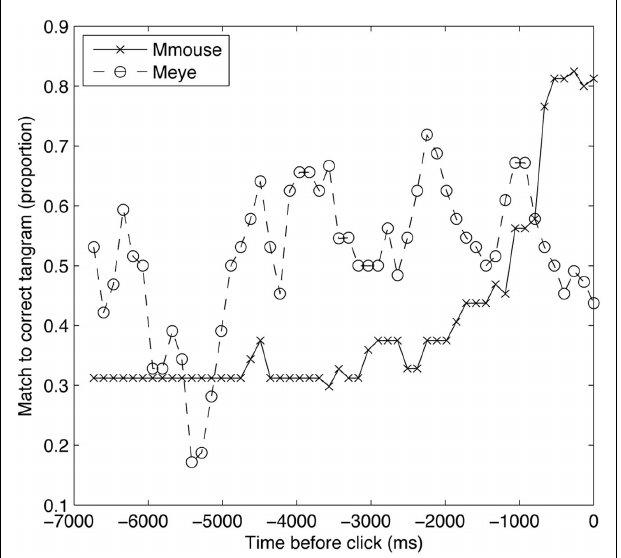
FIGURE 4 | Eye and mouse fixations on the correct tangram shape in the seconds before